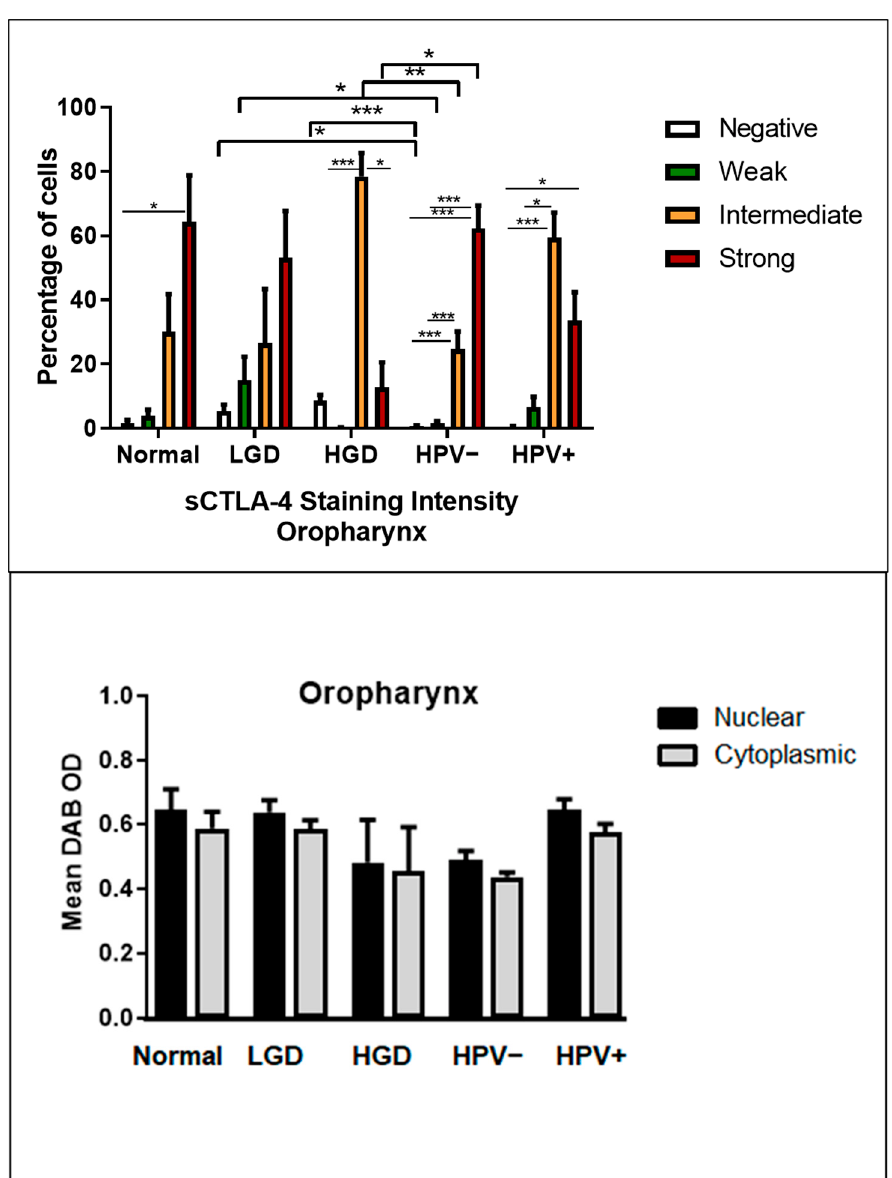
represents zoomed-in views of the cell detection, with the scale bar representing 100 μ m and the inset showing the exact site of the magnified view.